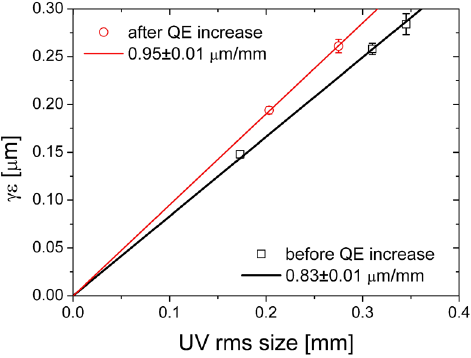
FIG. 5. Thermal emittance increase following QE change at 25 : 7 MV = m .